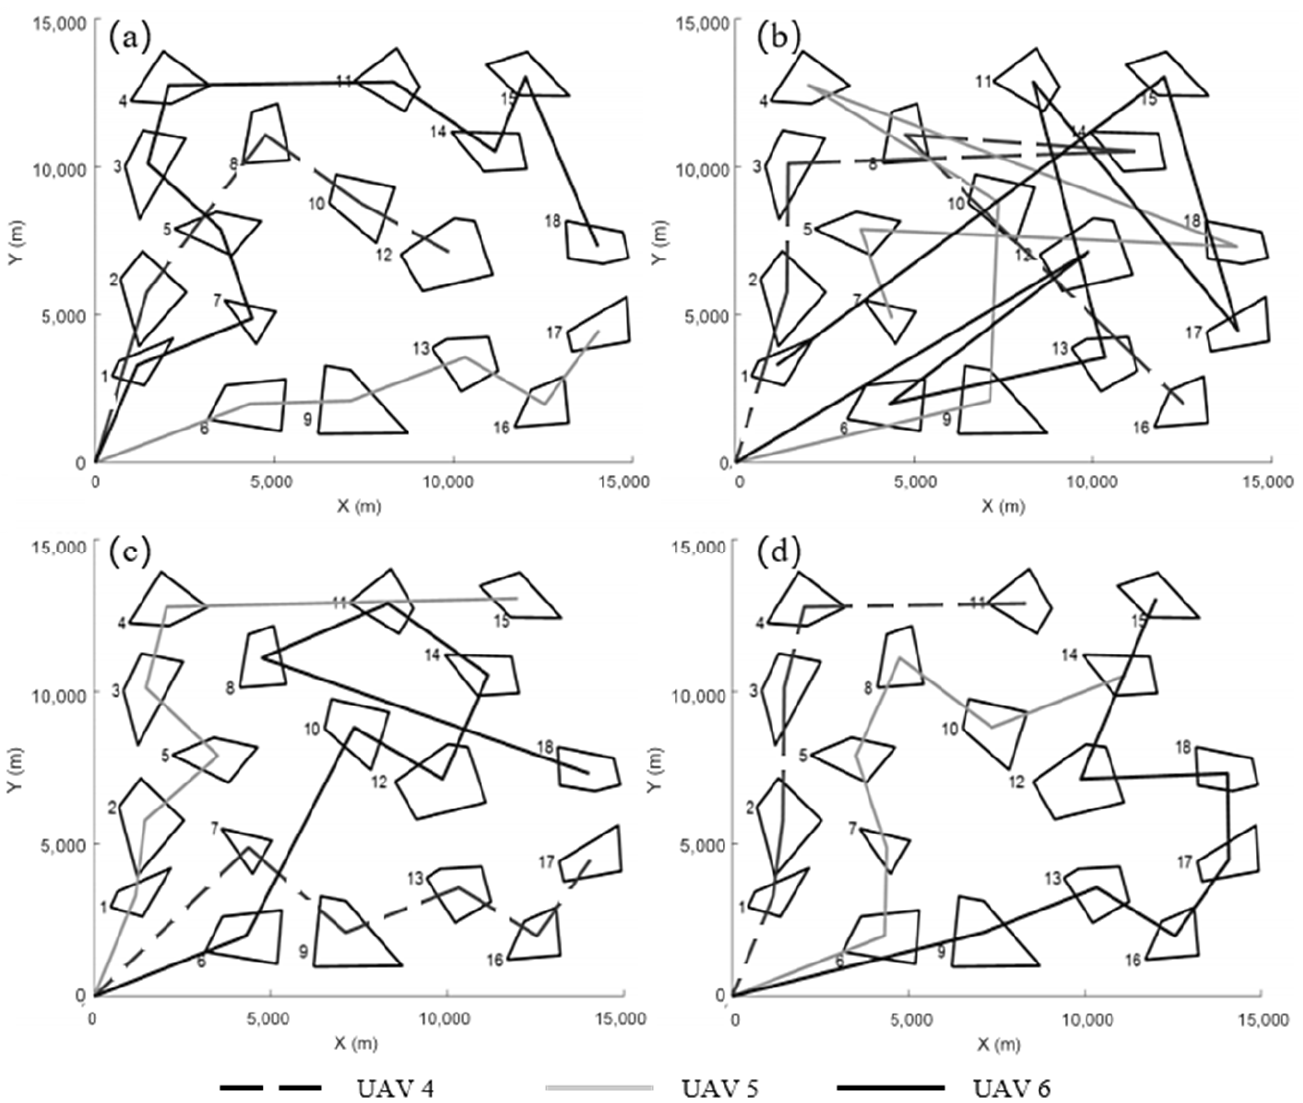
Figure 8. The CPP of heterogeneous UAVs for four algorithms: ( a ) SDF, ( b ) LAF, ( c ) HETRF, ( d ) MCR.